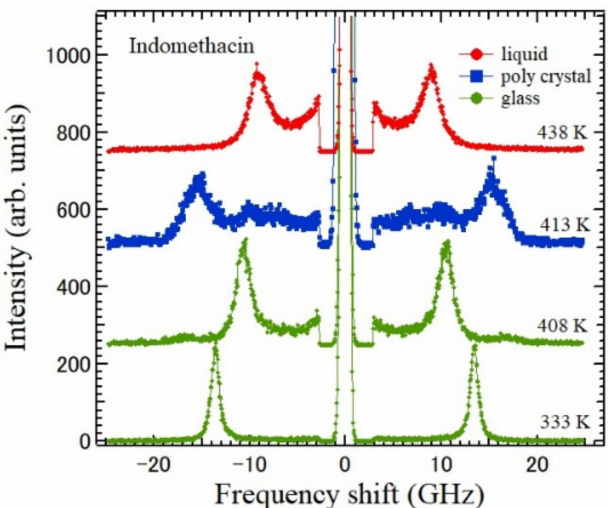
Figure 15. Temperature dependence of Brillouin scattering spectra of the liquid, glass, and polycrys- talline states of indomethacin. The glassy states at 333 and 408 K, polycrystalline phase at 413 K after crystallization from glass, and liquid states at 438 K